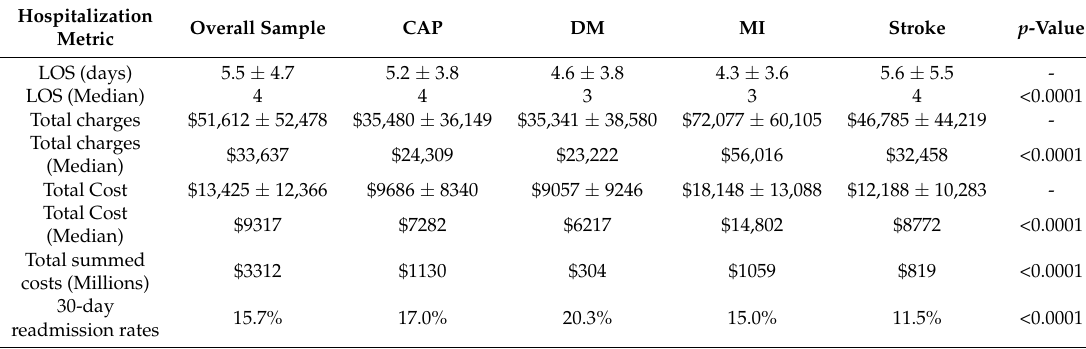
Table 4. Length of hospital stay, costs, and 30-day readmission rates among older adults hospitalized for targeted